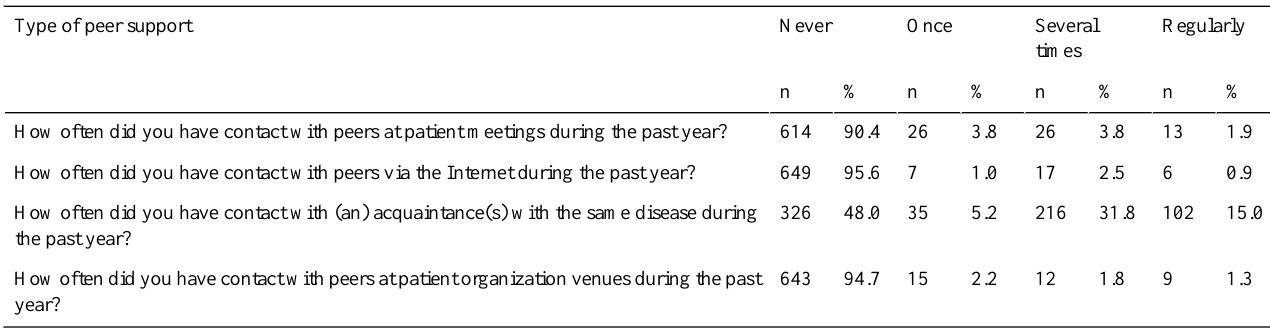
Table 2. Use of peer support (n = 679) during the preceding